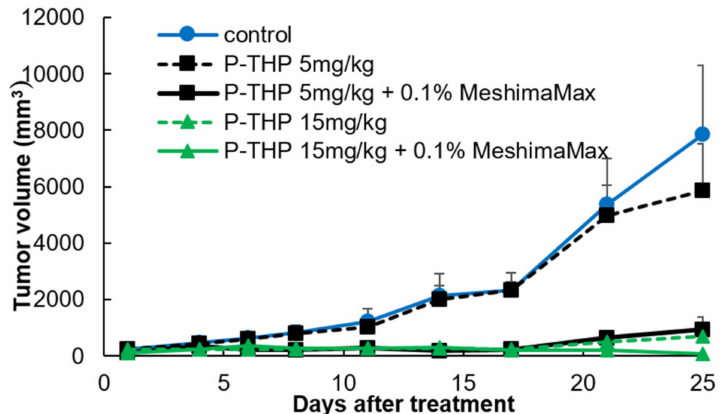
Figure 4. Antitumor e ff ect of MeshimaMax in combination with anticancer nanomedicine HPMA copolymer conjugated pirarubicin (P-THP), against mouse sarcoma S180 solid tumor. MeshimaMax treatment was carried out from day 7 after S180 tumor cell inoculation when the tumor had grown to 7–8 mm in diameter and P-THP was injected i.v. at day 7 after tumor inoculation. Data are mean ±